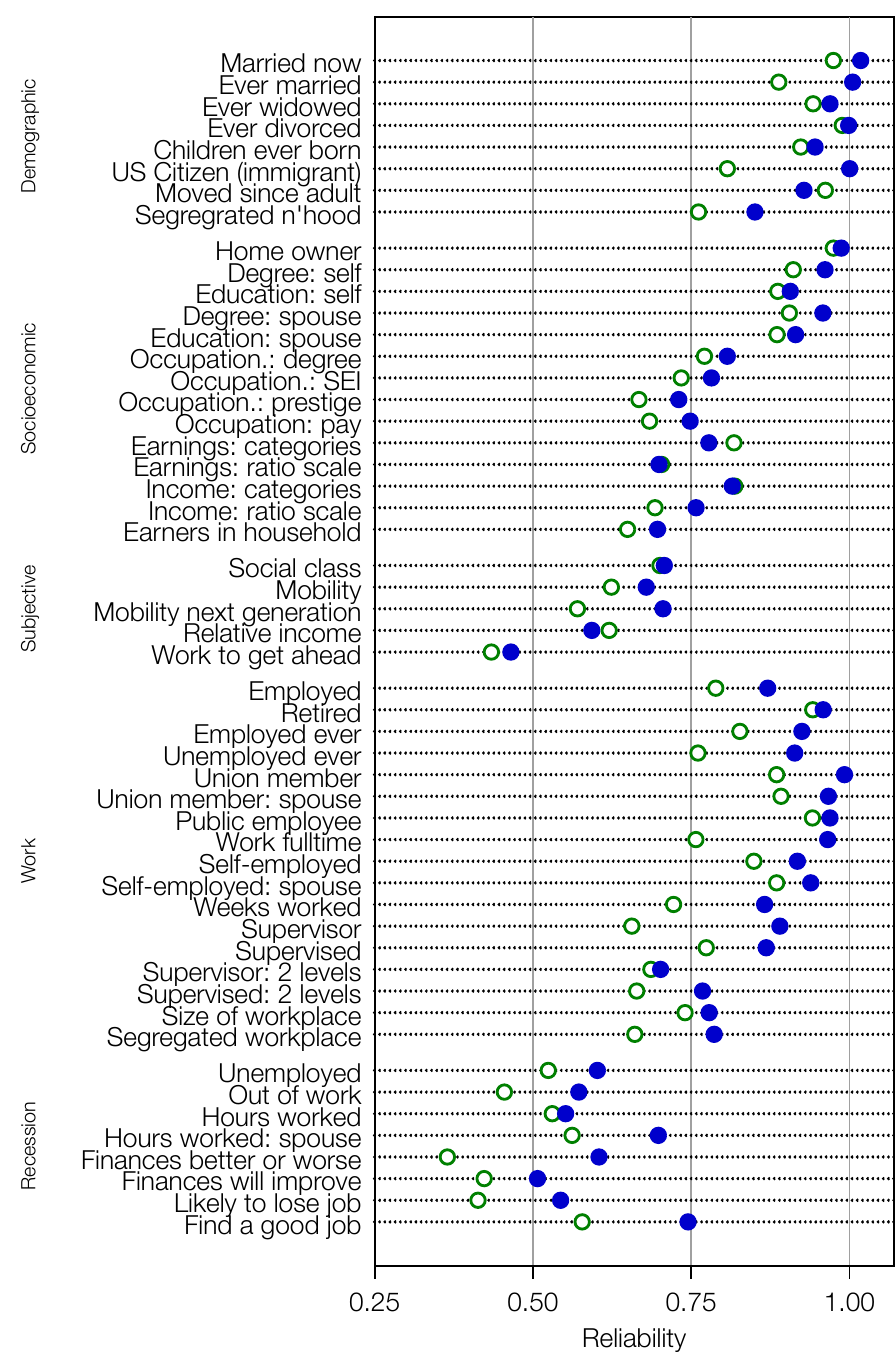
Figure 3: Reliability estimates for items about demographic, socioeconomic, and work facts plus subjective socioeconomic